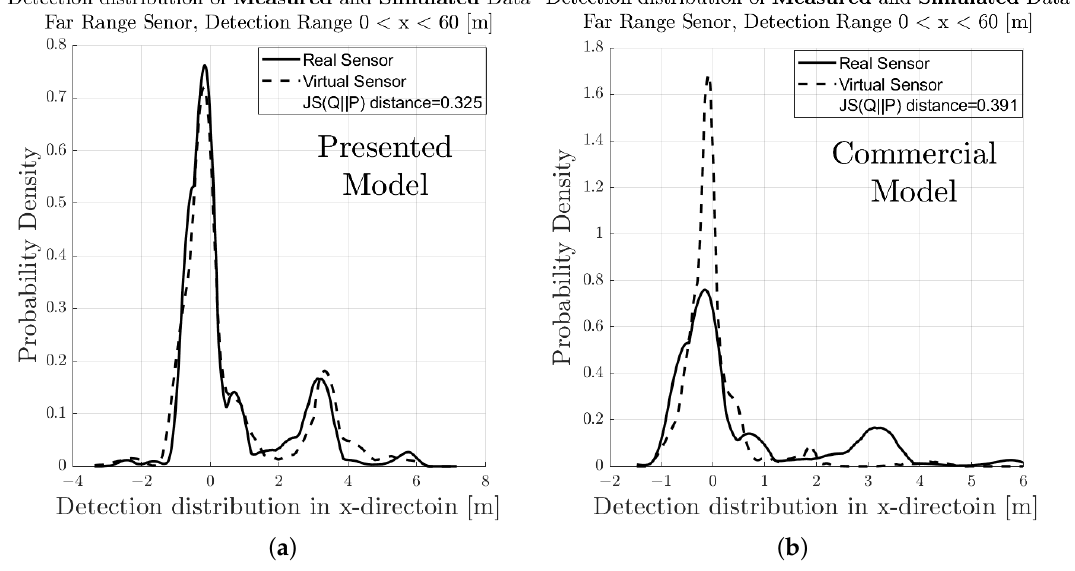
Figure 12. Visual comparison and evaluation of the probability distribution function (PDF) of the deviation of the measured and simulated radar point clouds with respect to the reference point in the near-range detection sector. ( a ) PDF of the deviation in the x -direction from P ref ( x , y ) of the real sensor and sensor model presented in this paper. ( b ) PDF of the deviation in the x -direction from P ( x , y ) of the real sensor and sensor model for commercial applications. ref